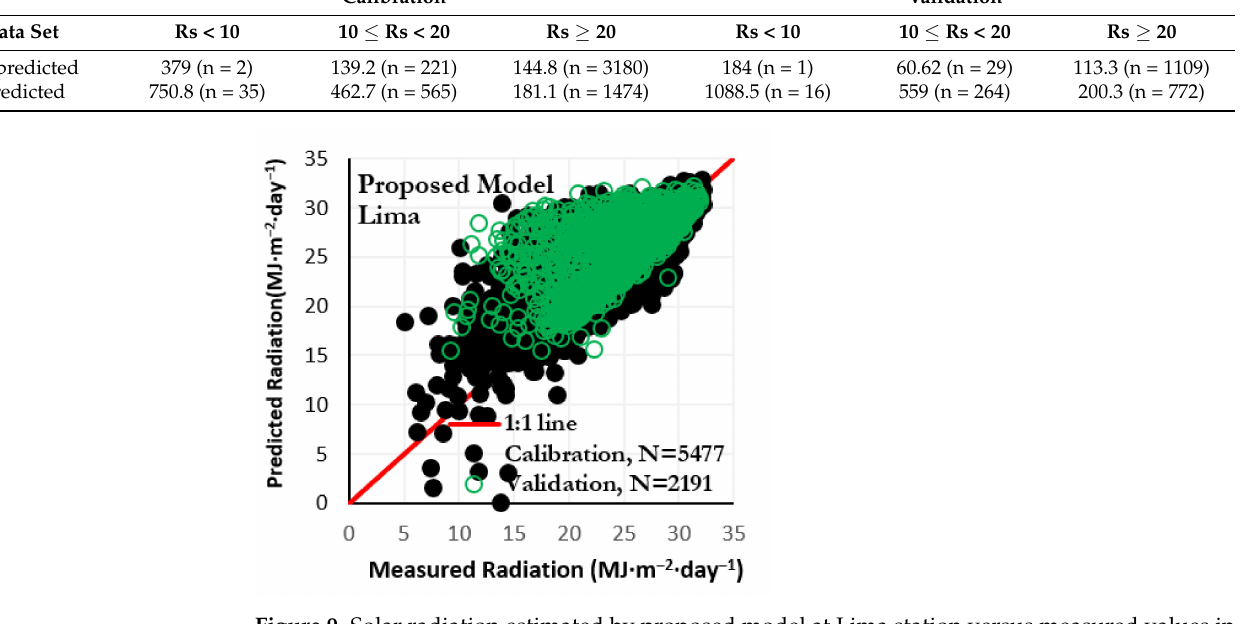
Figure 9. Solar radiation estimated by proposed model at Lima station versus measured values in calibration and validation sets.